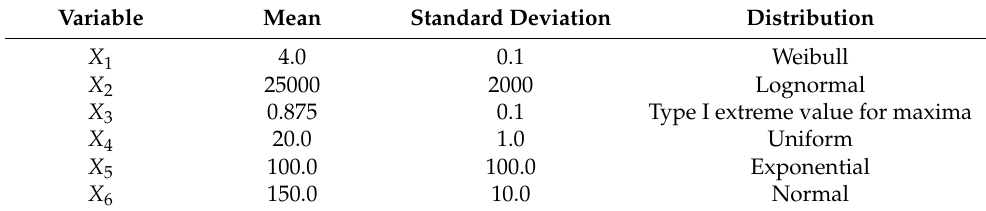
Table 3. Random variables and their parameters in Example 2.